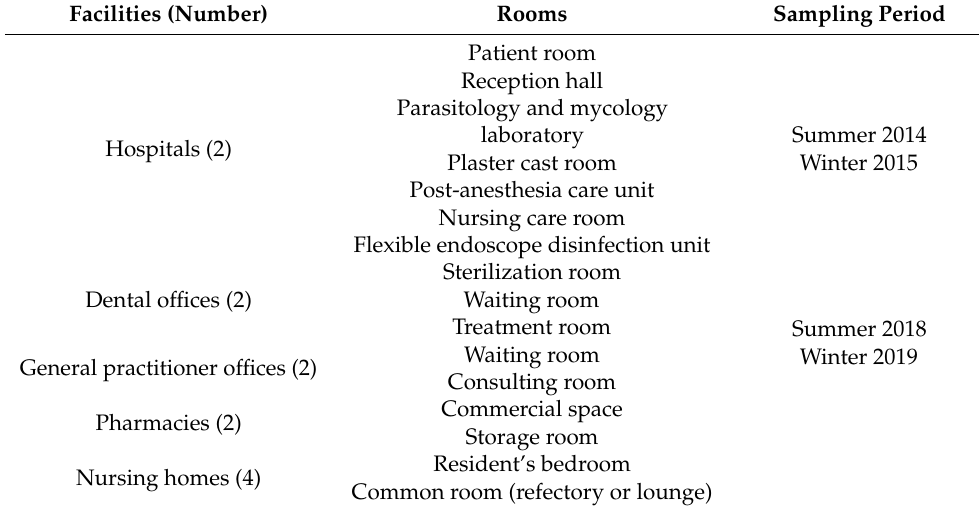
Table 2. Sampling sites and